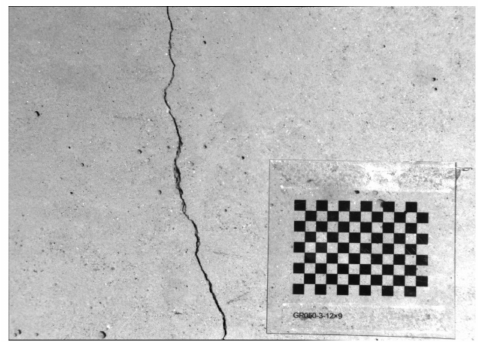
Figure 3. Calculation principle of the scale method.